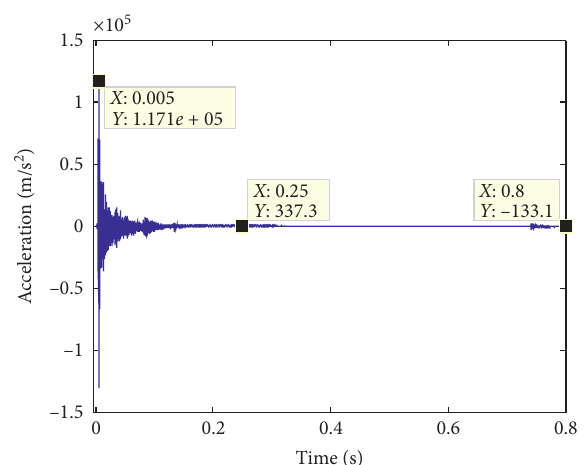
Figure 5: Typical acceleration response of inner